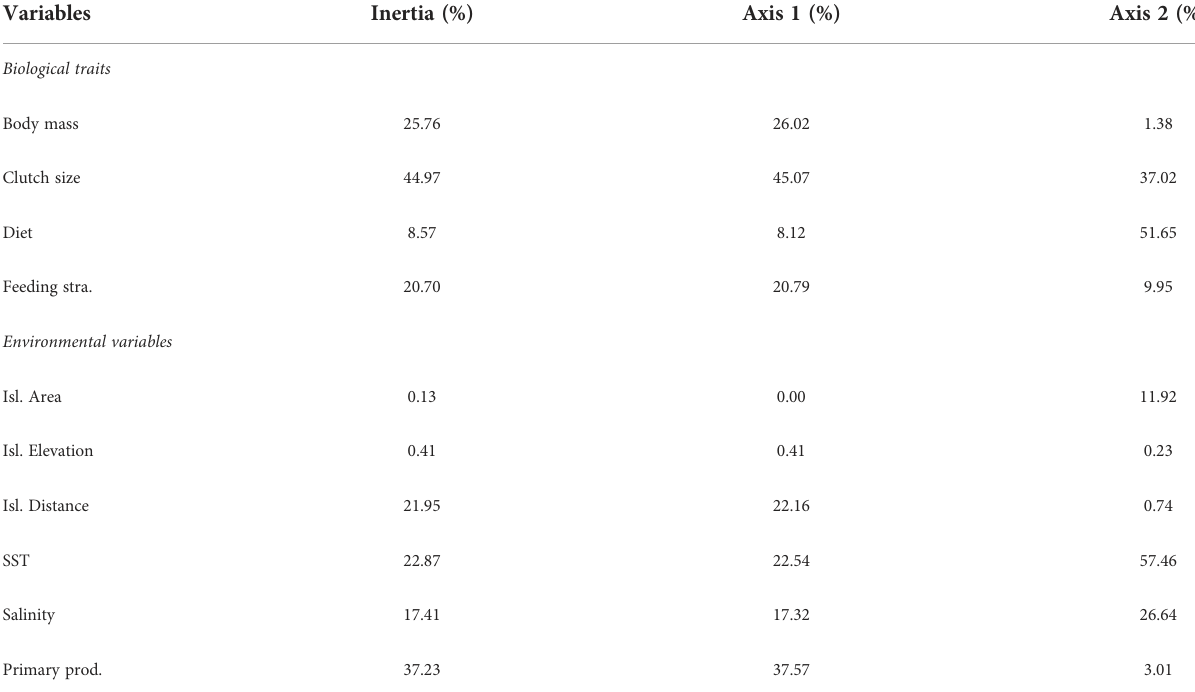
TABLE 2 Contributions (%) of individual traits and environmental variables to the total inertia to both RLQ axes. Variables